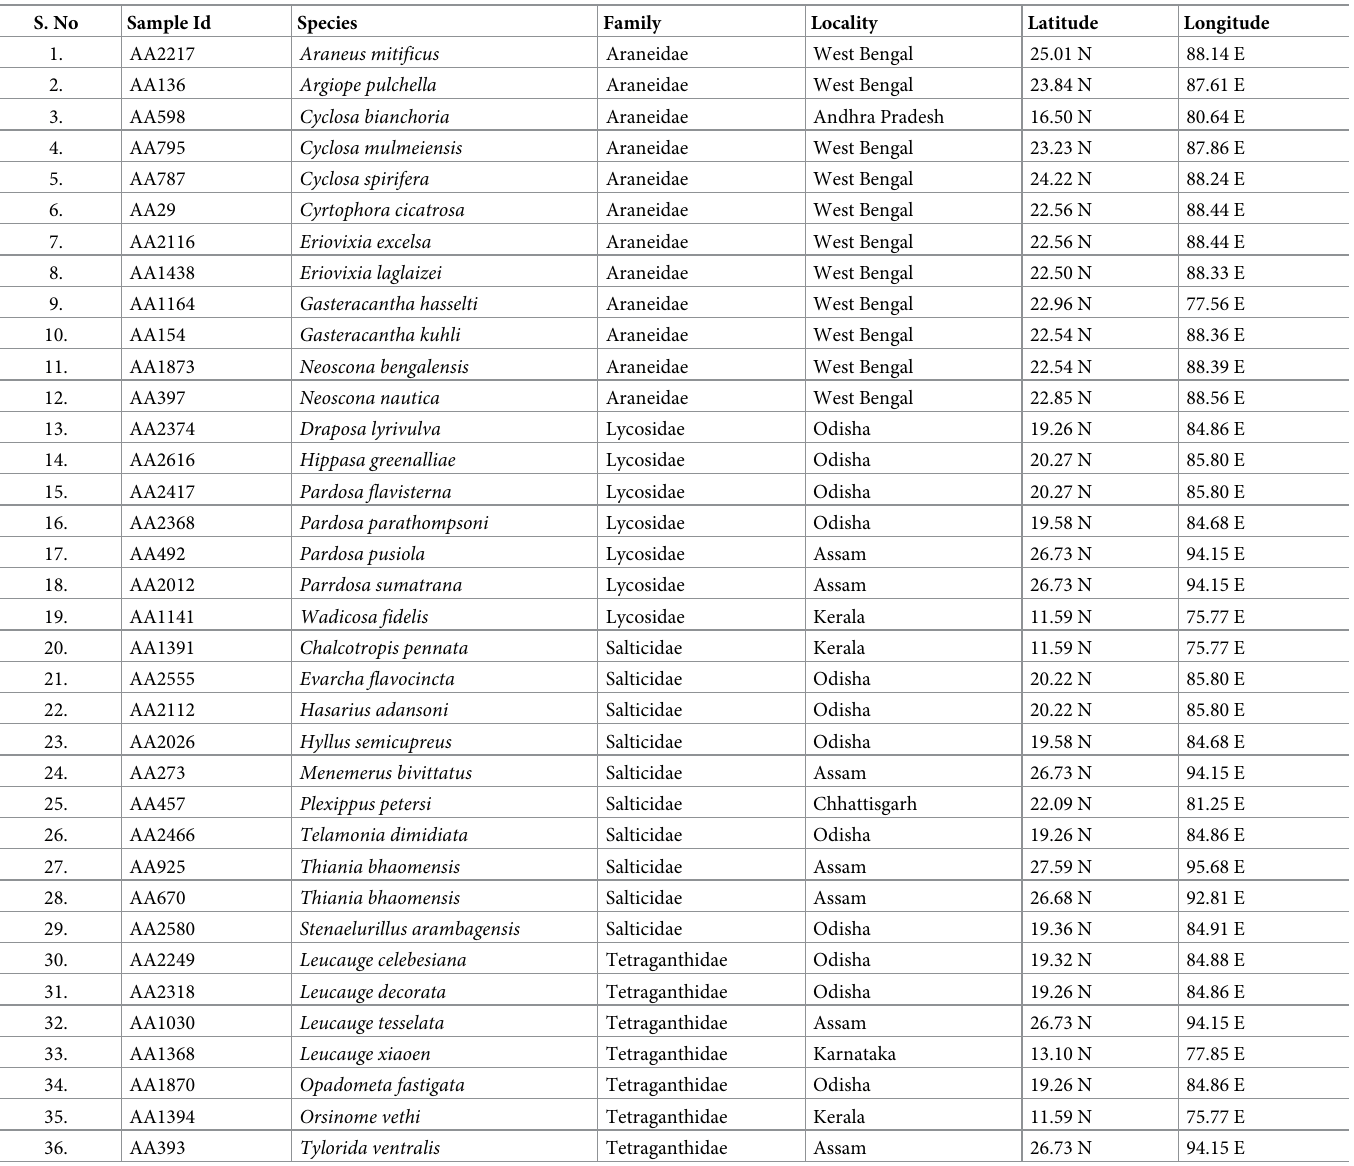
Table 1. Collection details of the Species of four spider families with their sample